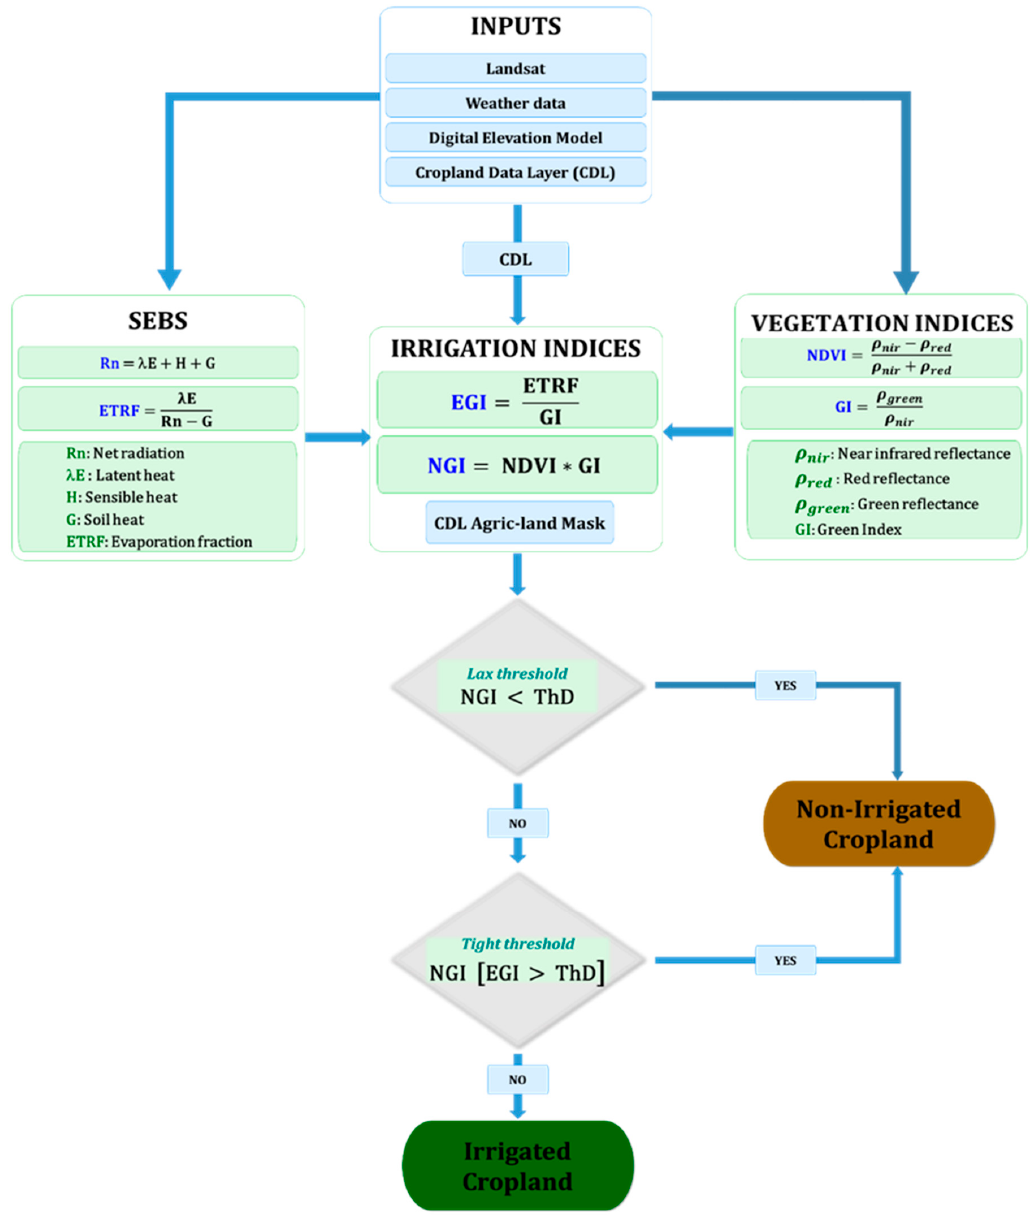
Figure 6. NDVI-Evaporation Fraction-Green Index (NEG) Irrigation classification scheme flow diagram. Thd = Threshold.